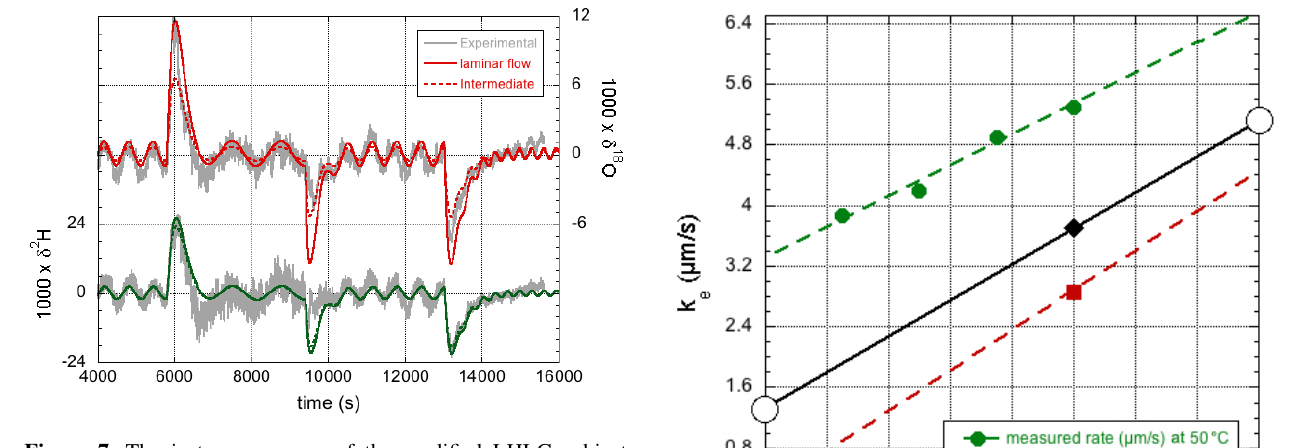
Figure 7. The isotope response of the modified LHLG subject to stepwise changes in the water flow rate. Improved simulations (compared with those in Fig. 5) are obtained with k e = 1µms − 1 and effective fractionation factors for the limiting case of fully lam- inar flow.